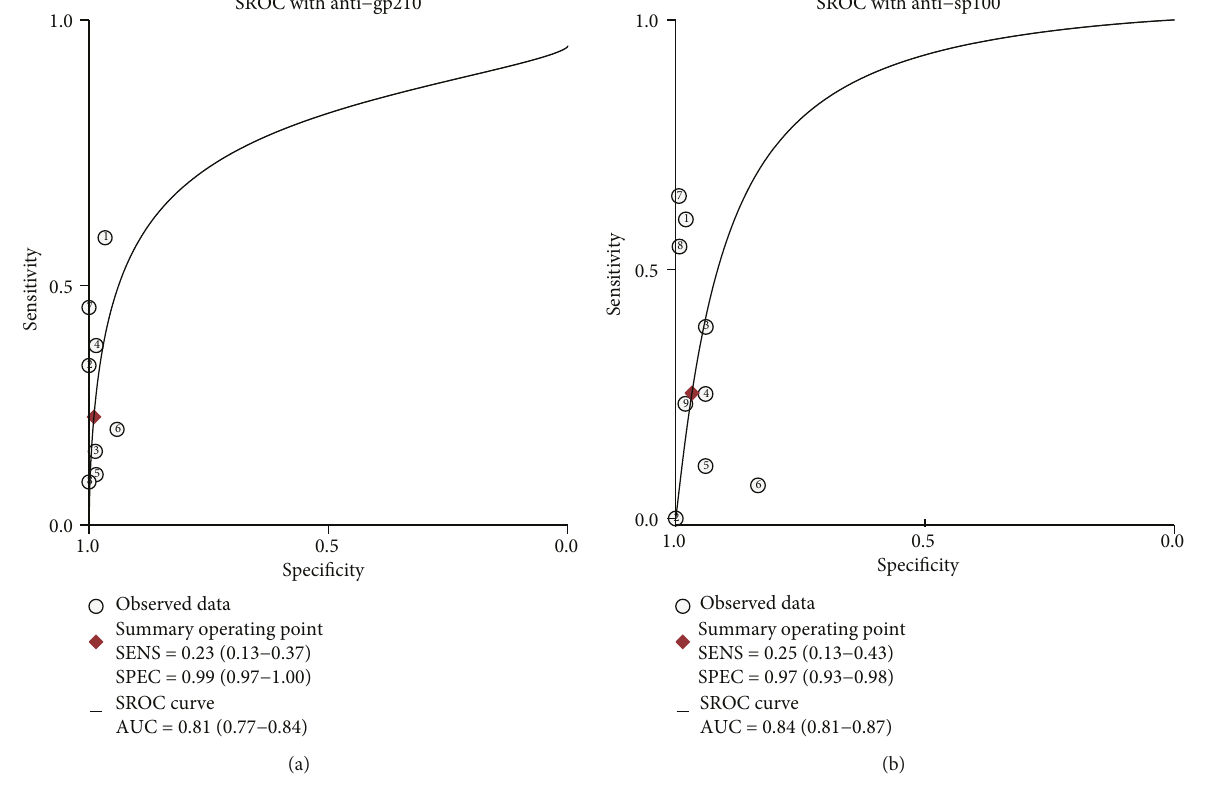
Figure 5: The SROC curve of anti-gp210 (a) and anti-sp100 (b) tests for the diagnosis of PBC. The summary receiver operator characteristic (SROC) curve was used for evaluating the global summary of test performance and the relationship between sensitivity and speci fi city. The area under the SROC (AUSROC) curve represented the overall performance of the detection method. Abbreviations: SROC: summary receiver operating characteristic; AUC: area under curves; PBC: primary biliary